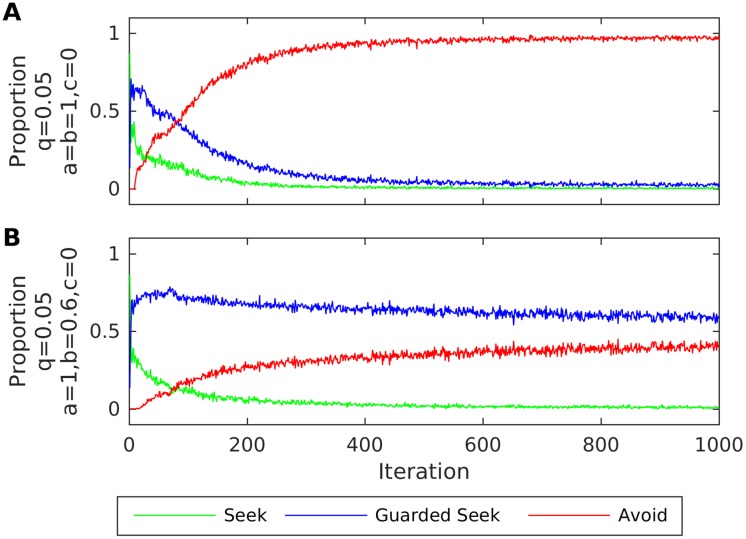
Avoidant and disorganised attachment with exteroceptive cues.Mean (over repetitions) proportion each action was chosen over all iterations. A: Proportions for an infant paired with a highly unresponsive caregiver (q = 0.05) with no ACEs (a = b = 1, c = 0). B: Proportions for an infant paired with a highly unresponsive caregiver (q = 0.05) with misleading ACEs about subsequent Ignore behaviour (a = 1, b = 0.6, c = 0).